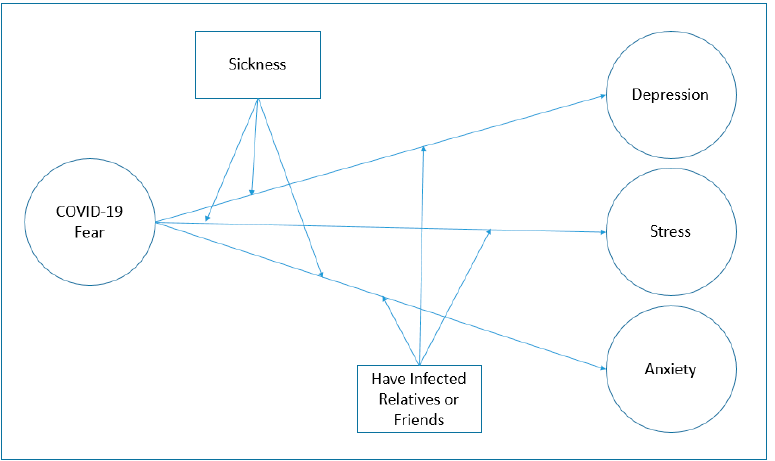
Figure 1. Conceptual Diagram of Model.